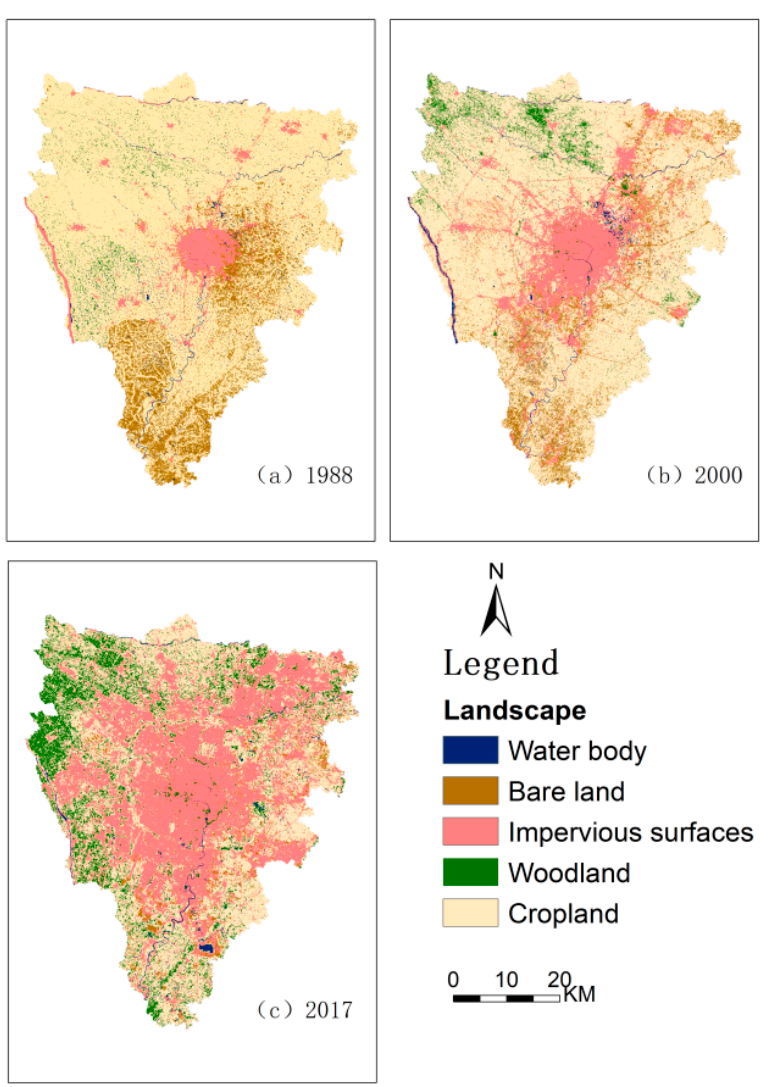
Figure 2. (a–c) are the landscape classification maps in 1988, 2000, and 2017 Figure 2. (a), (b) and (c) are the landscape classification maps in 1988, 2000, and 2017 respec- tively.